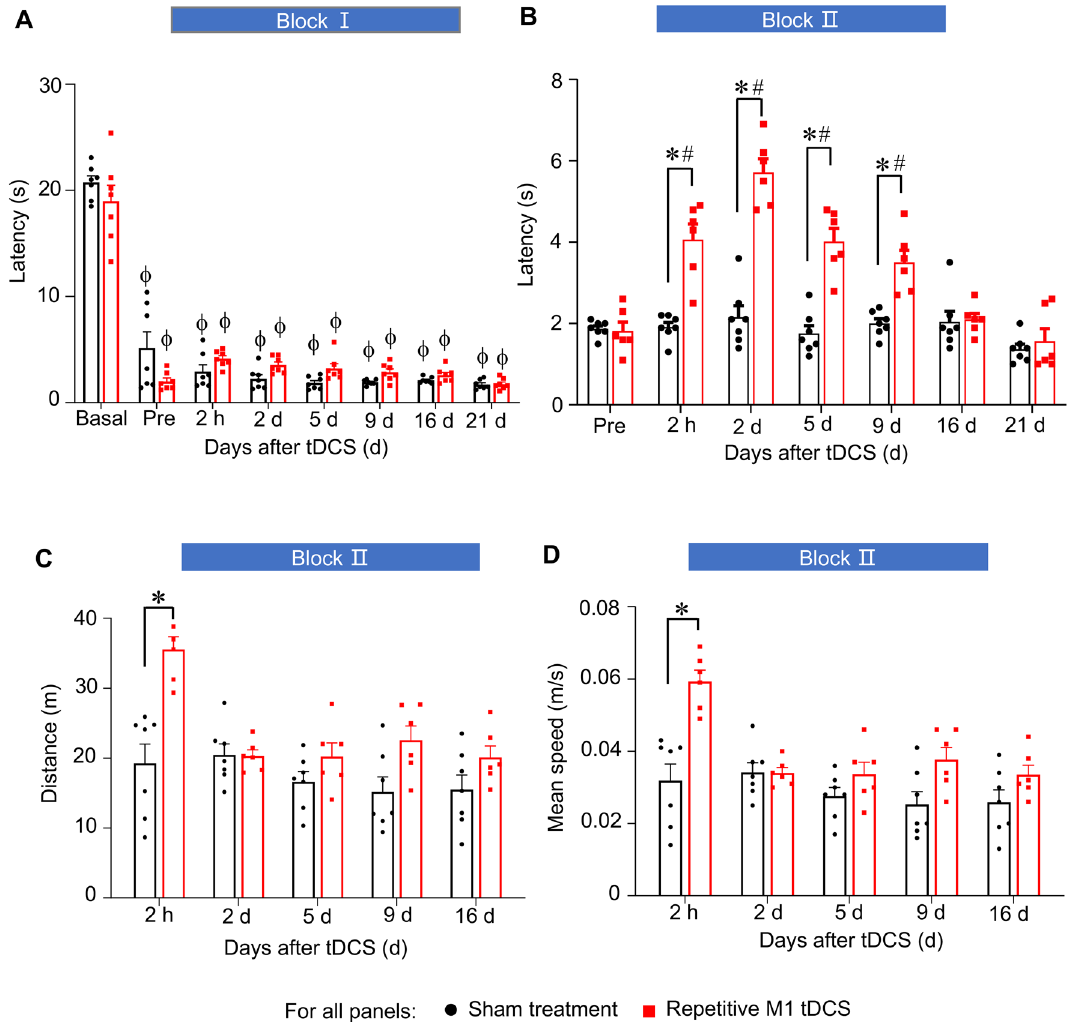
Figure 3. Comparison of the impact of the application of Block I and Block II anodal M1 tDCS over early and the chronic phase of neuropathic pain post-nerve injury (SNI), respectively, on cold allodynia and motor function. ( A,B ) Partial, significant reversal of allodynia to cold, shown in form of latency of nociceptive responses to 5° temperature, by repetition of anodal M1 tDCS in chronic phase post-SNI (Block II), but not by the first 5-day cycle of M1 tDCS over the early phase post-SNI (Block I) in comparison with the respective sham treatment group on. ( C,D ) Early and short-lasting enhancement of locomotion parameters by anodal M1 tDCS (Block II). n = 7 mice for the sham treatment group and n = 6 mice for repetitive M1 tDCS group; ANOVA for repeated measures was performed, followed by Sidak’s test for multiple comparisons; *indicates p < 0.05 as compared to the corresponding sham group, # indicates p < 0.05 as compared to the pre-stimulation value within each group. indicates p < 0.05 as compared to the basal value within each group Data are represented as mean + /− ϕ protection against mechanical allodynia is strong in the tDCS group), which amounted to 43 days post-SNI (i.e. a chronic neuropathic pain stage). In both sham-treated and M1 tDCS mice, the innocuous stimulus of 0.16 g did not elicit any change over baseline Fos expression in the rostral anterior cingulate cortex (rACC; Fig. 5A,B), infralimbic cortex (IL; Fig. 5A,D), midcingulate cortex (MCC; Suppl. Figure 2A), M1 and M2 motor cortices (Suppl. Figure 2B,C), hindlimb area of the primary somatosensory cortex (S1HL; Suppl. Figure 2D), prelimbic cortex (PrL; Suppl. Figure 2E) and the ventroposterolateral and ventroposteromedial thalamic nuclei (VPL and VPM; Suppl. Figure 2F,G). In the brain, the posterior Insula (PI) (Fig. 5A,C), the lateral periaqueductal grey (LPAG) and the ventrolateral periaqueductal grey (vlPAG) (Fig. 6A–C) showed a clear increase in Fos expres- sion upon innocuous mechanical paw stimulation of sham-treated SNI mice; this increase did not occur in SNI mice that received repetitive M1 tDCS (Figs. 5A,C, 6A–C). Thus, the only 3 regions (PI, LPAG, vlPAG) that showed a specific activation corresponding to mechanical allodynia in sham mice were not recruited in mice with M1 tDCS, highlighting their role in mechanisms underlying M1 tDCS-induced protection against neuro- pathic mechanical allodynia and aversion to light touch.